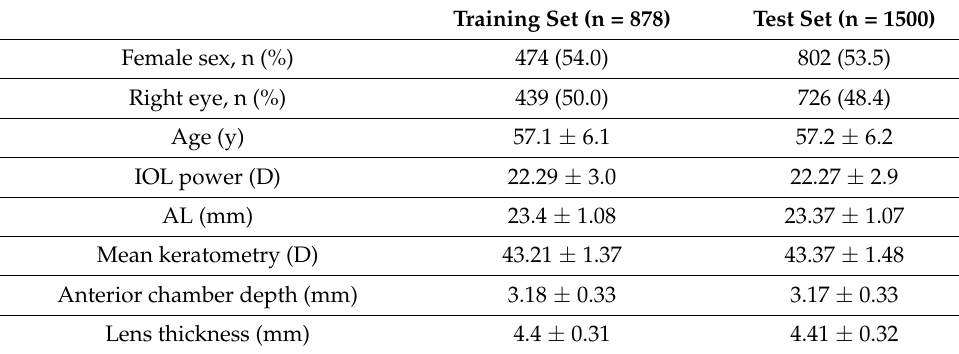
Table 1. Patients Characteristics in the Training Set and the Test